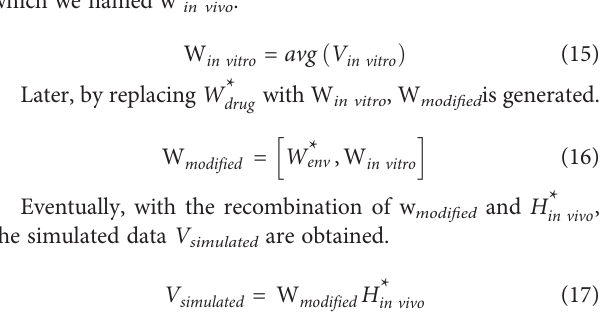
FIGURE S2 | The bar graphs for the factors obtained from each system of validation data set after factor analysis. (A) Represents the reduced eigen values (REVs) calculated by factor analysis of each factor in in vivo (upper), and the ratios of contribution calculated based on REVs of in vivo (down) data. (B) Represents the reduced eigen values (REVs) calculated by factor analysis of each factor in in vitro (upper), and the ratios of contribution calculated based on REVs of in vitro (down) data. FIGURE S3 | Results of validation dataset. (A) In the comparison with original in vivo data (light blue), the drug-responding component achieved